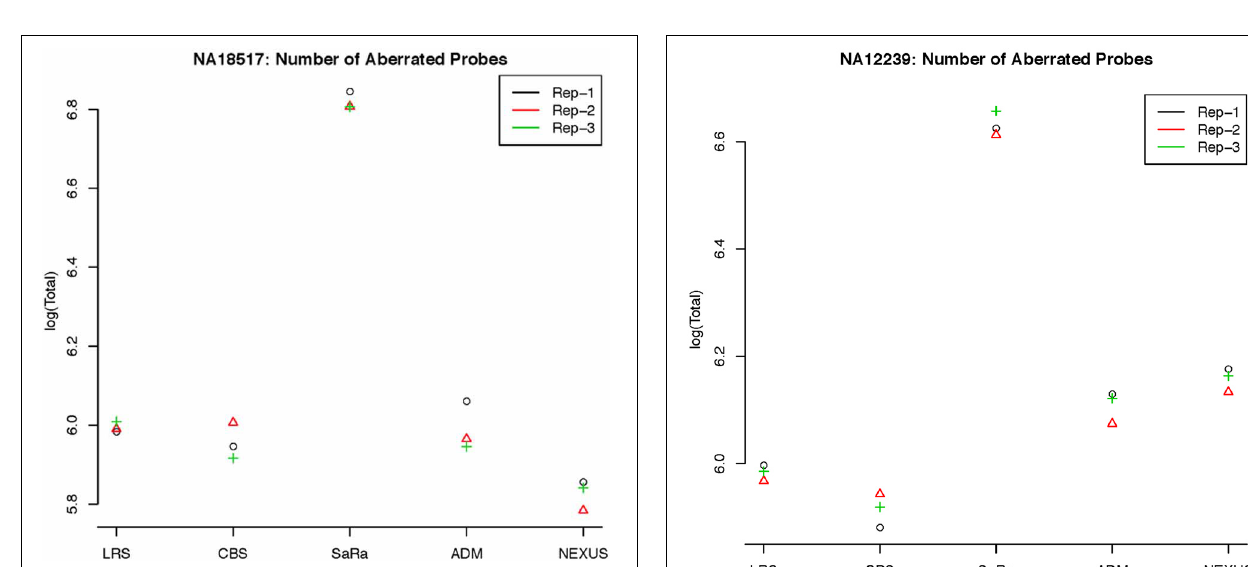
deviation. (B) shows the same figure for the non self-self hybridization. The differences between the algorithms are more apparent and it is clear how the threshold rules may affect the calls for different algorithms differently.